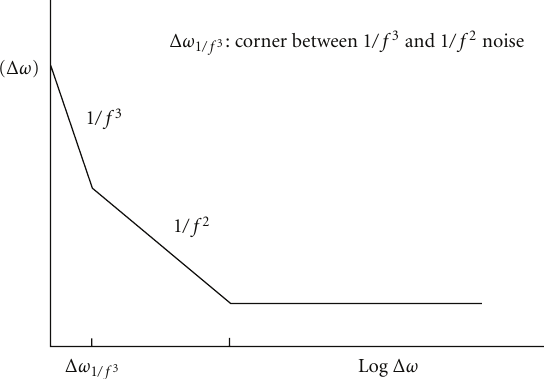
Figure 9: Typical phase noise plot of output oscillation versus o ff set Δ ω from the center frequency of the negative resistance bu ff er cell.